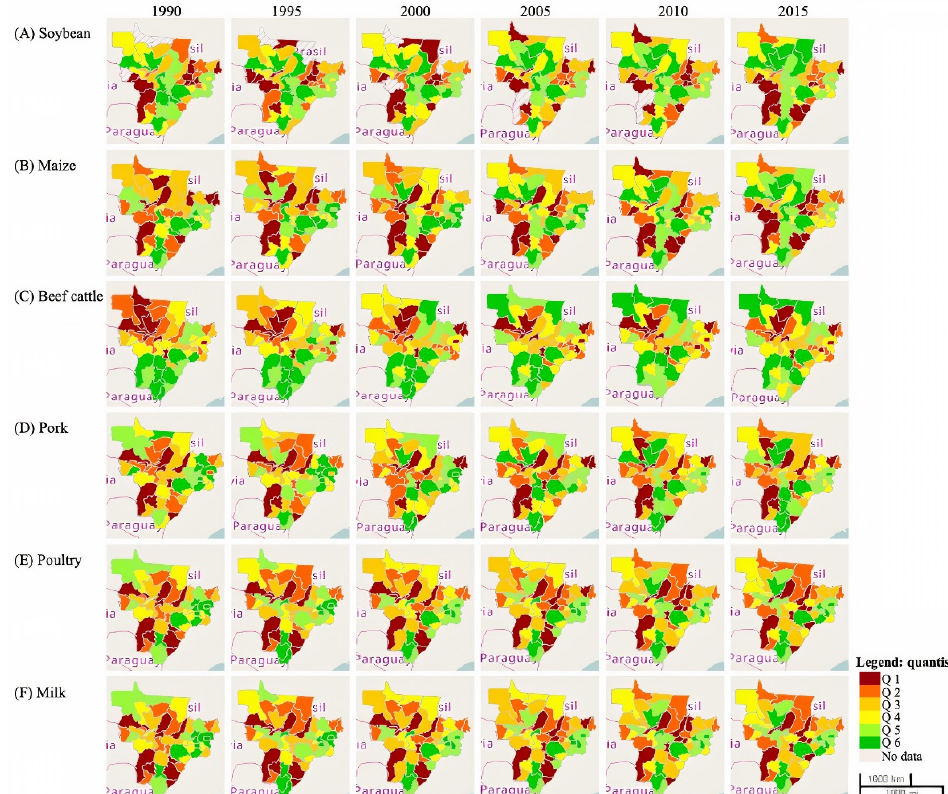
Figure 3. Six quantiles of quantity produced for soybeans ( A ), maize ( B ), beef cattle ( C ), milk ( D ), pork ( E ), and poultry ( F ) in the Brazilian midwest region for the years 1990, 1995, 2000, 2005, 2010, and 2015. Source: Elaborated by authors based on [22,23]. Notes: Each midwest microregion map is distributed in six quantiles (frequency distribution of quantity produced into equal groups) for each of the six products analysed in each year (interval of five years from 1990 to 2015). The quantiles are presented from the lowest to the highest quantity produced, that is, from Quantile 1 (Q1 or strong red in colour palette) to Quantile 6 (Q6 or strong green in colour palette).